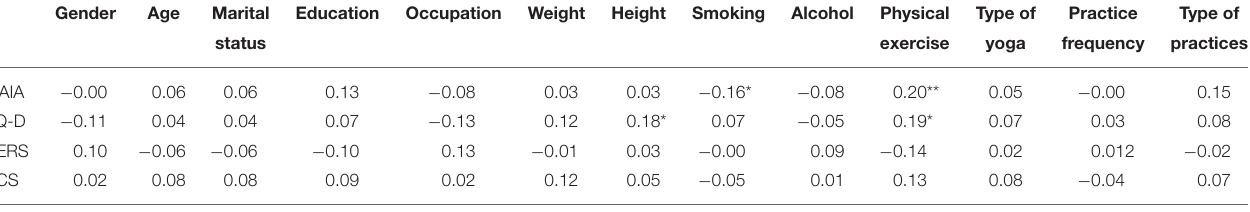
TABLE 4 | Bivariate correlations of the outcome variables with sociodemographic characteristics, life habits, and aspects of yoga practice in the Indian participants. Gender